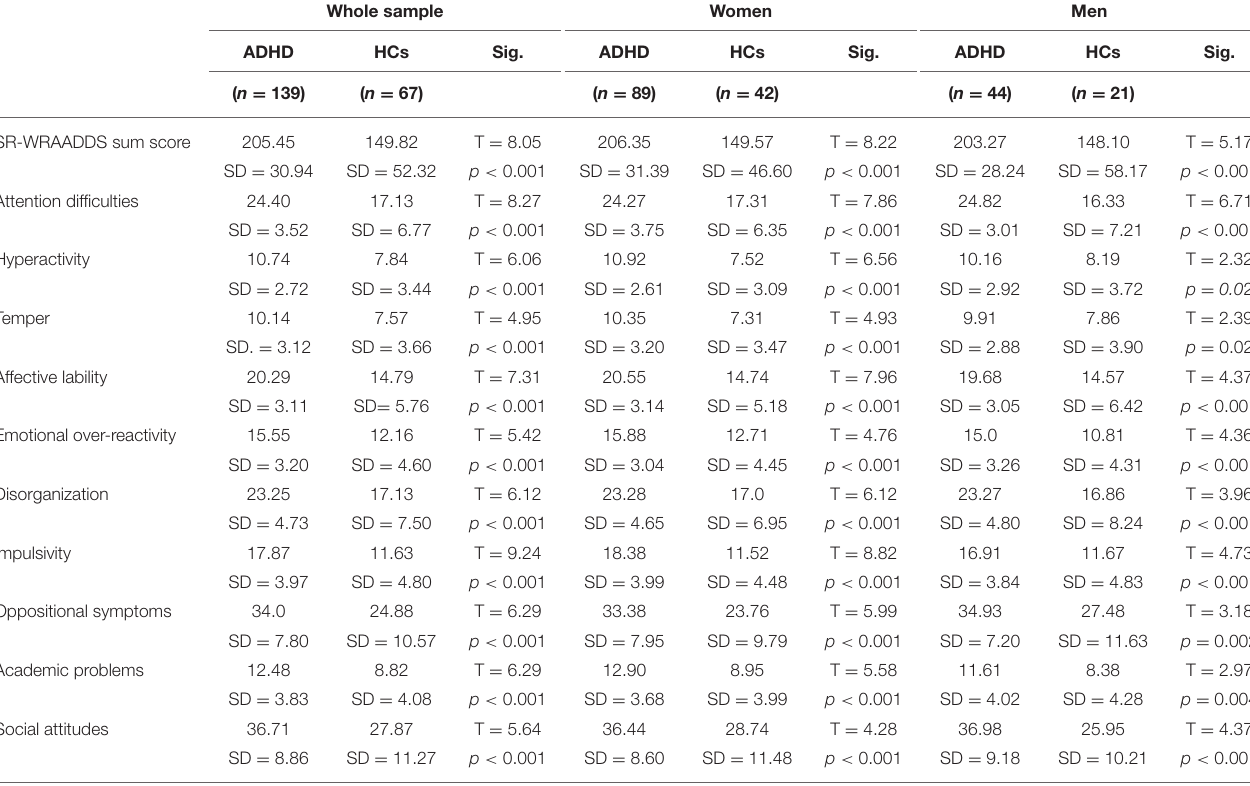
TABLE 1 | Comparison between mean SR-WRAADDS sum score and subscale scores in individuals with and without ADHD. Whole sample